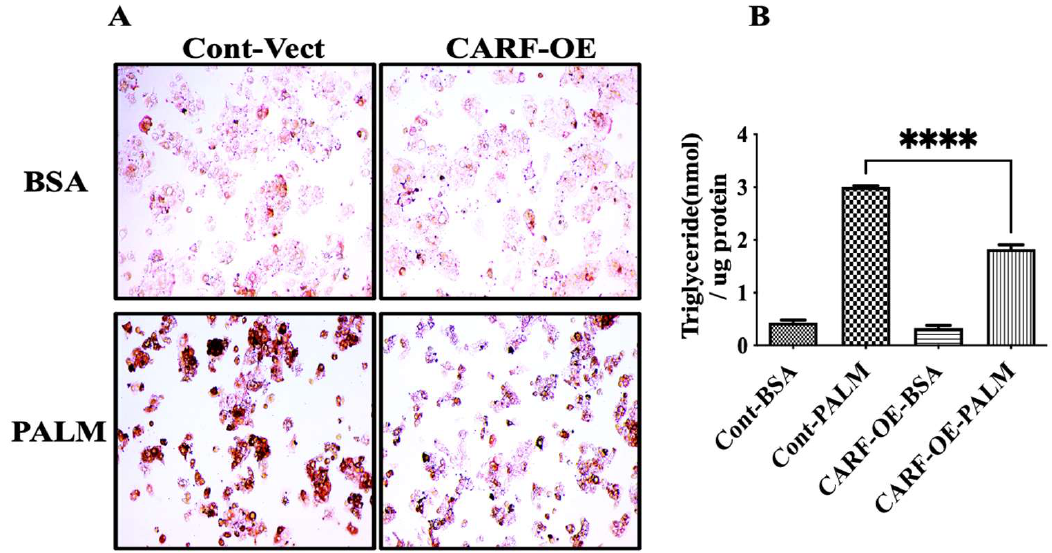
Figure 3. Effect of CARF on ectopic fat accumulation in HepG2 cells. Oil-Red-O staining of HepG2 cells show fat accumulation ( A ). Upper panels show the images of vehicle (BSA)-treated cells, and lower panels show the images of palmitate-treated cells. The left and right panels show the images of vector-control and CARF-overexpressing (CARF-OE) cells, respectively. Oil-Red- O stain shows the reduction of ectopic fat accumulation in CARF-OE cells. ( B ) Shows the level of TG accumulation in HepG2 cells after treating the cells as described in ( A ) (data are shown from 3 independent treatments). One-way ANOVA followed by Holm–Sidak’s multiple comparison test were conducted to show the differences (**** p < 0.0001).